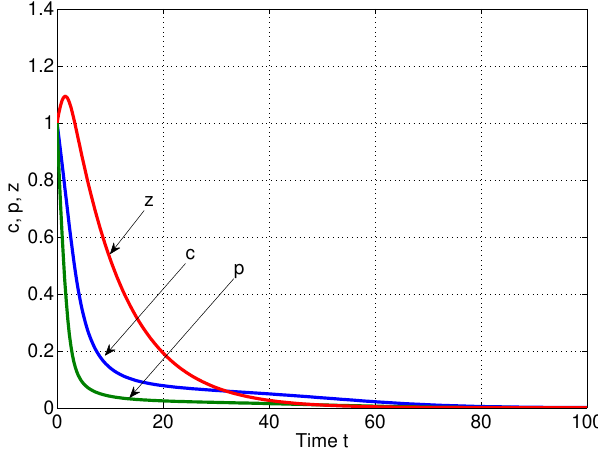
Figure 3. (cid:98) E ( (cid:98) c , (cid:98) p , (cid:98) z ) of system (1) does not exist when A = 1.7 < B = 1.8 and the remaining parameters are chosen from set (10), i.e., the dynamics of the system (1) change abruptly, resulting in oxygen depletion and plankton extinction for a small value of A .